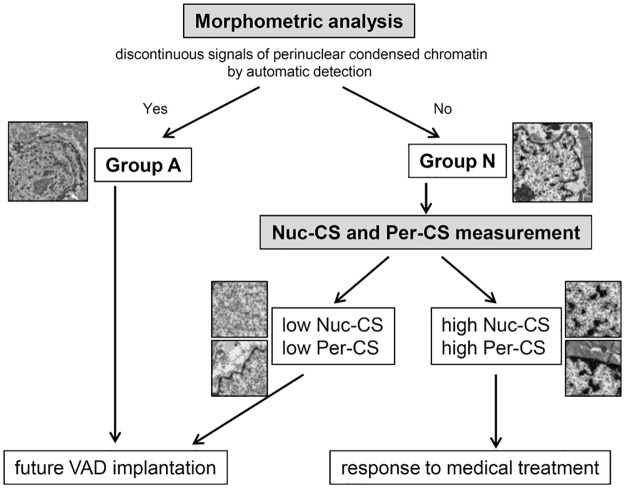
Algorithm for DCM Therapy Based on Myocardial Biopsy Parameters.The first step is morphometric analysis of cardiomyocyte nuclei. When chromatin in the nuclear periphery is discontinuous and there is a homogeneous aggregation of particles in the nucleoplasm, the patient is classified as Group A, which is associated with poor prognosis. When a patient does not have these characteristics, a second step, which involves additional quantitative analysis, is added. Based on the chromatin scores Nuc-CS and Per-CS, a treatment plan can be determined.